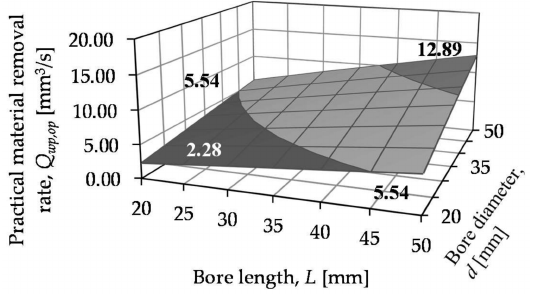
Figure 6. Q wp,op values of the combined procedure.